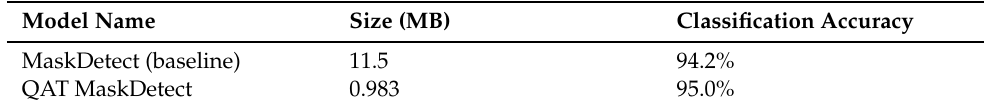
Table 2. Impact of quantisation-aware